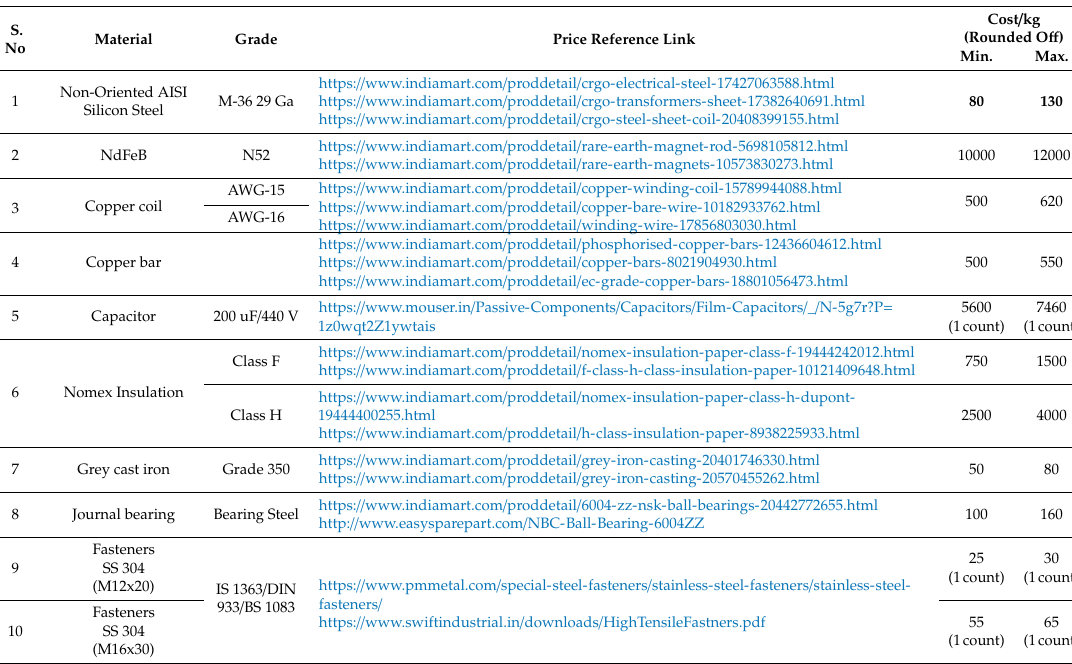
Table A3. References for cost